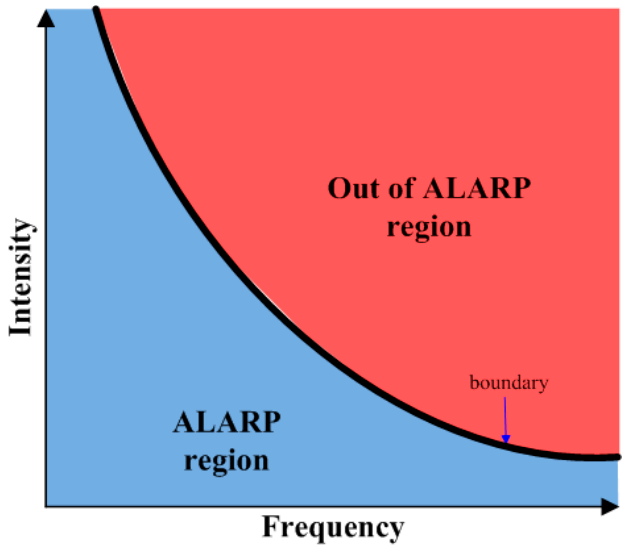
Figure 8. The ALARP region between frequency and magnitude.